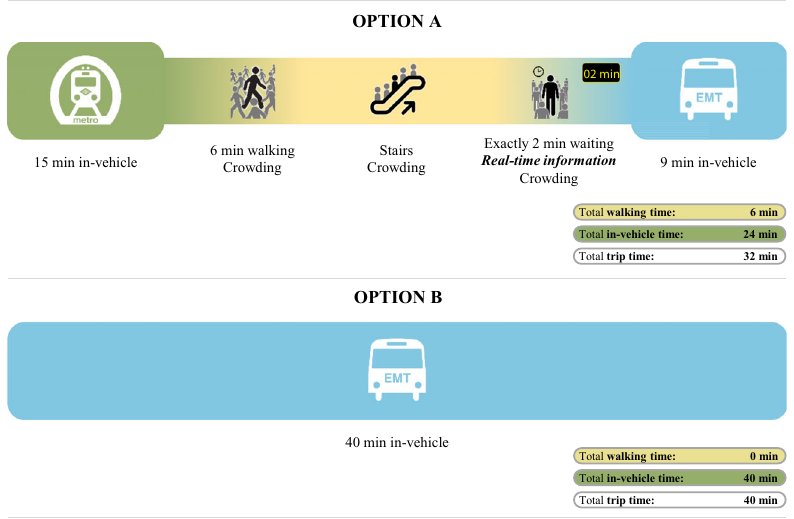
Fig. 2 Survey screenshot: choice situation between no-transfer and one-transfer